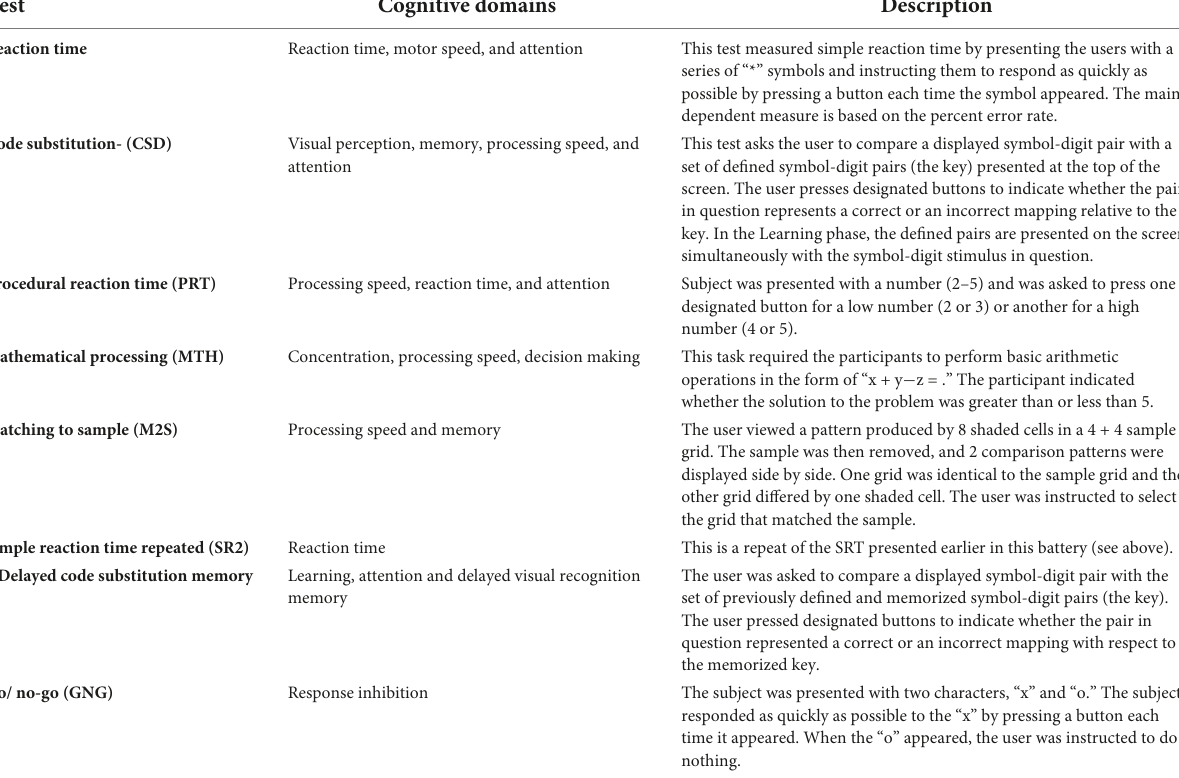
TABLE 2 Automated neuropsychological assessment measures (ANAM) test battery